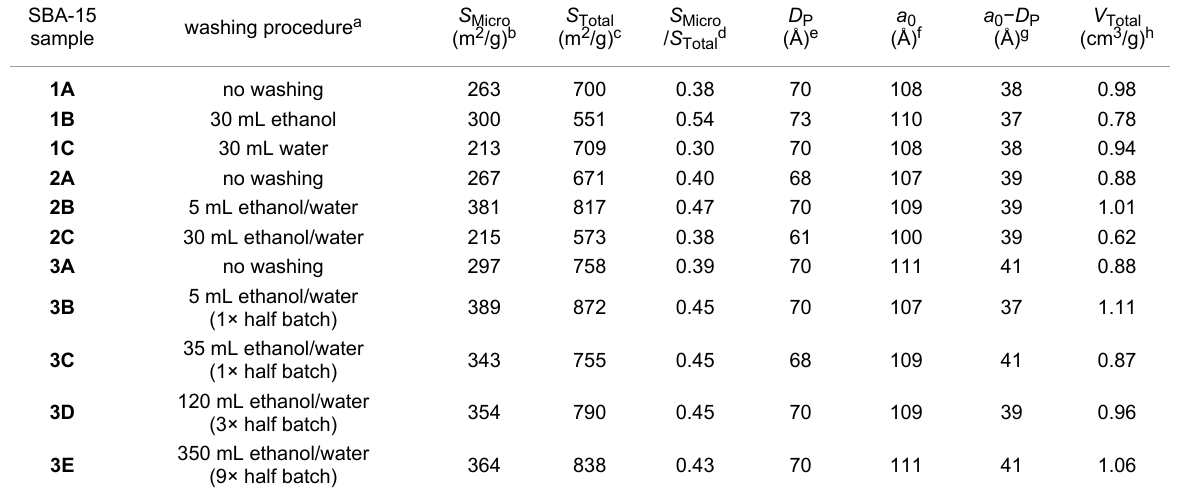
Table 1: Surface and porosity characteristics of SBA-15 samples washed with pure water, ethanol and a combination of ethanol and water. SBA-15 sample